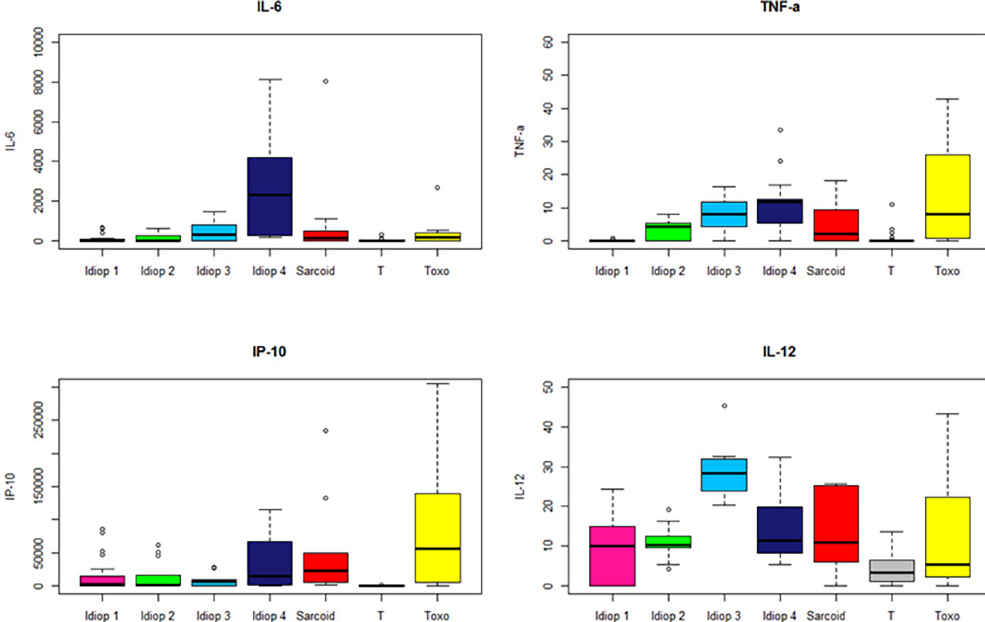
Fig 10. Boxplots of 4 immune mediators significantly elevated in the aqueous humor of patients within 4 sub-groups of idiopathic uveitis (Idiop 1, 2, 3 and 4): IL-6, TNF- α , IL-12 and IP-10, as compared to immune mediators in the aqueous humor of patients with uveitis related to sarcoidosis, TU (Toxo) and noninflammatory controls (T). Significant P values are noted in the upper part of each graph. A P value < 0.05 was considered significant.